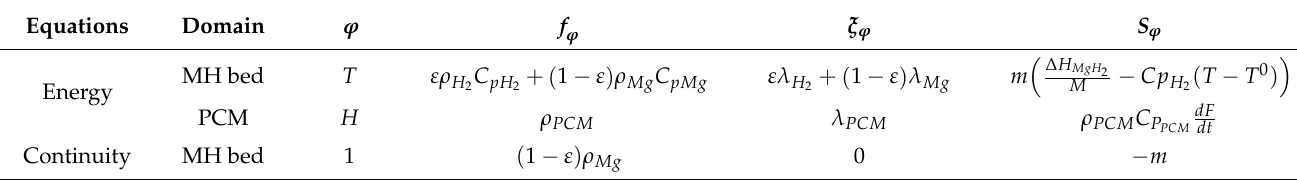
Table 1. The expression of the different terms of Equation (21)